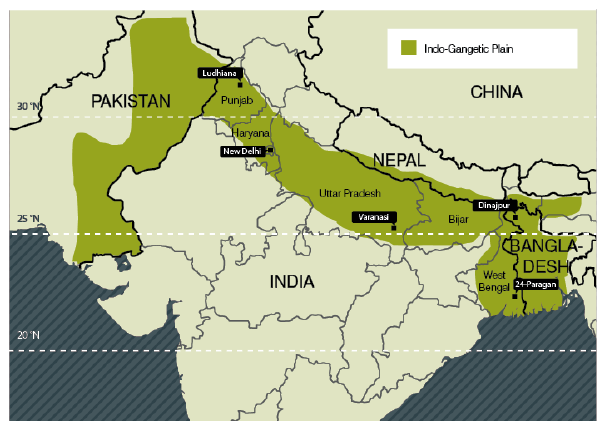
Figure 1. The Indo–Gangetic Basin (from the Australian Centre for International Agricultural Research as provided at: http://aciar.gov.